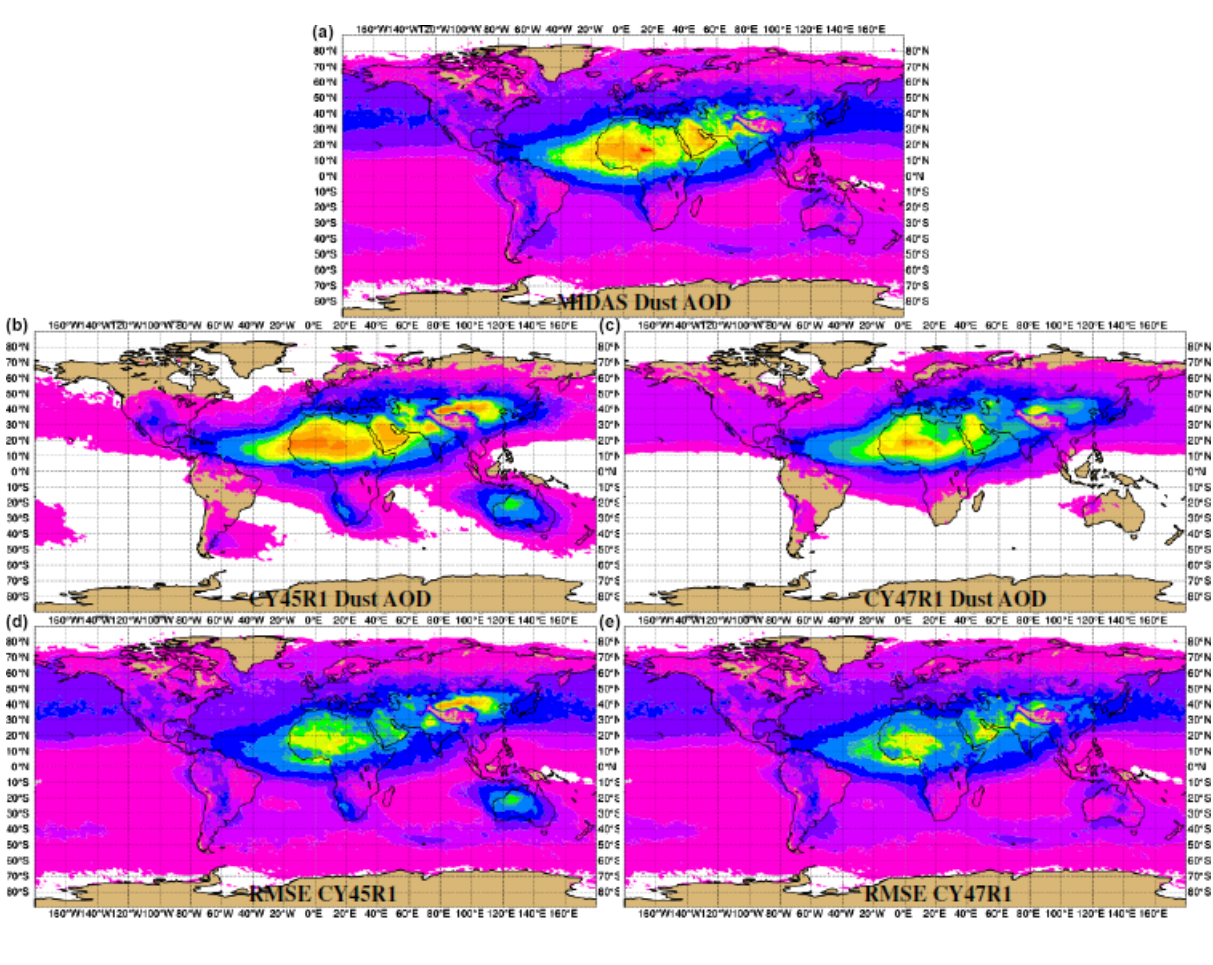
Figure 11. (a) The 2017 average MIDAS dust AOD at 550nm. Co-located 2017 average of dust AOD at 550nm simulated by IFS-AER CY45R1 (b) and CY47R1 (c) . The 2017 average daily RMSE of simulated dust AOD at 550nm for CY45R1 (d) and CY47R1 (e)